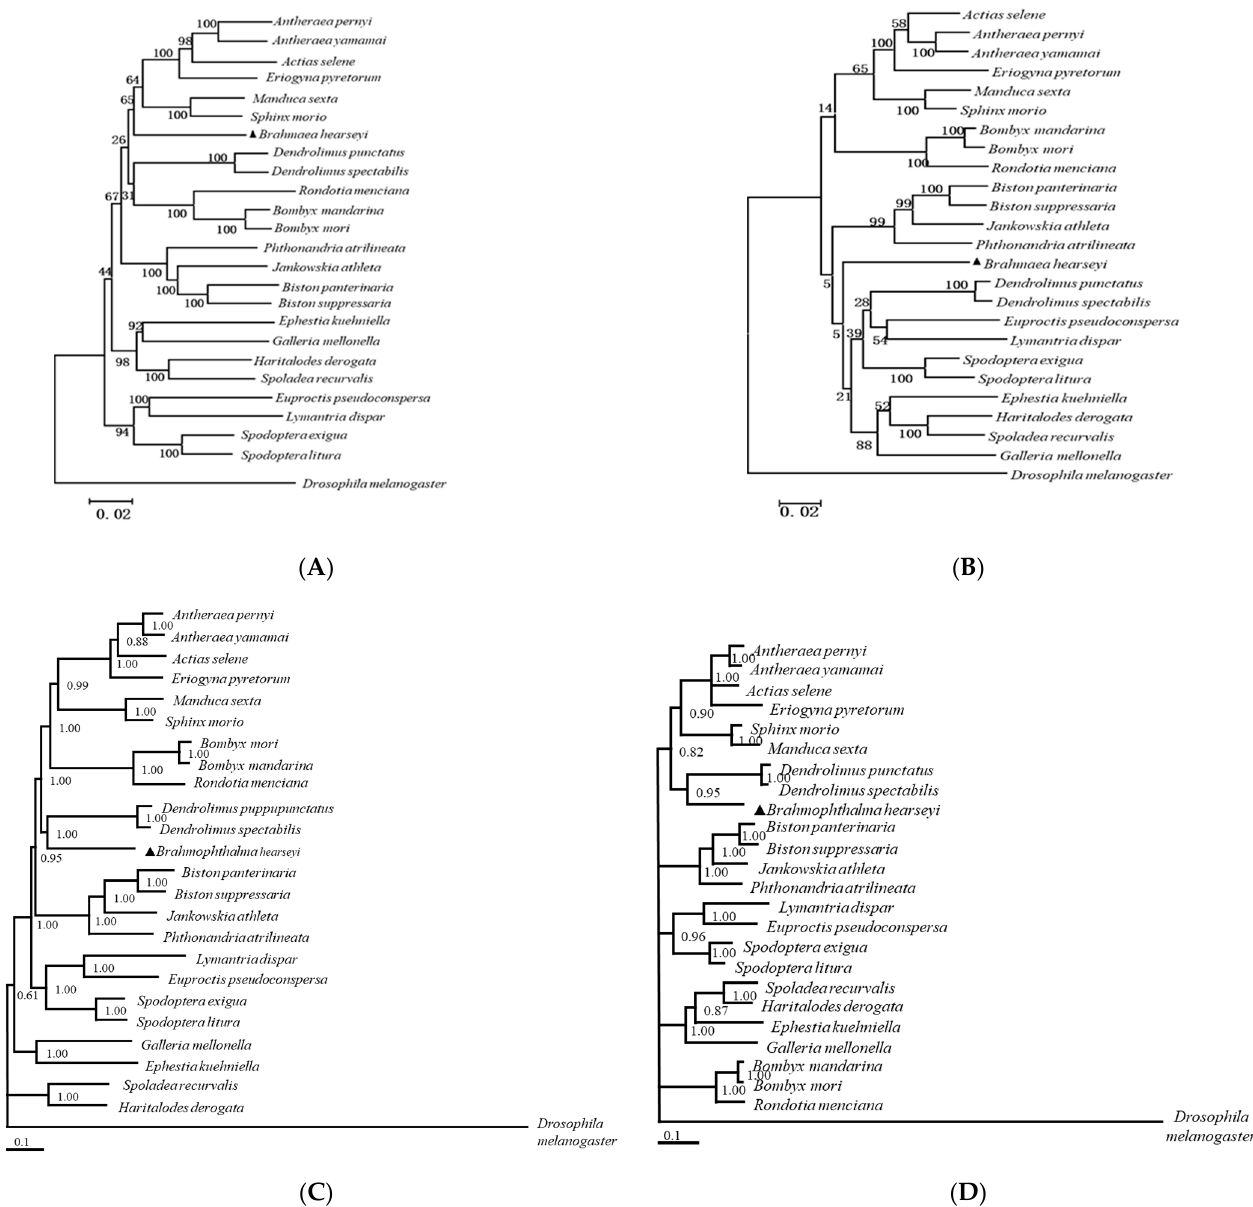
Figure 2. ( A ) Neighbor-joining tree based on the PCG dataset; ( B ) Neighbor-joining tree based on the rRNA dataset; ( C ) Bayesian inference tree based on the PCG dataset; ( D ) Bayesian inference tree based on the rRNA dataset.